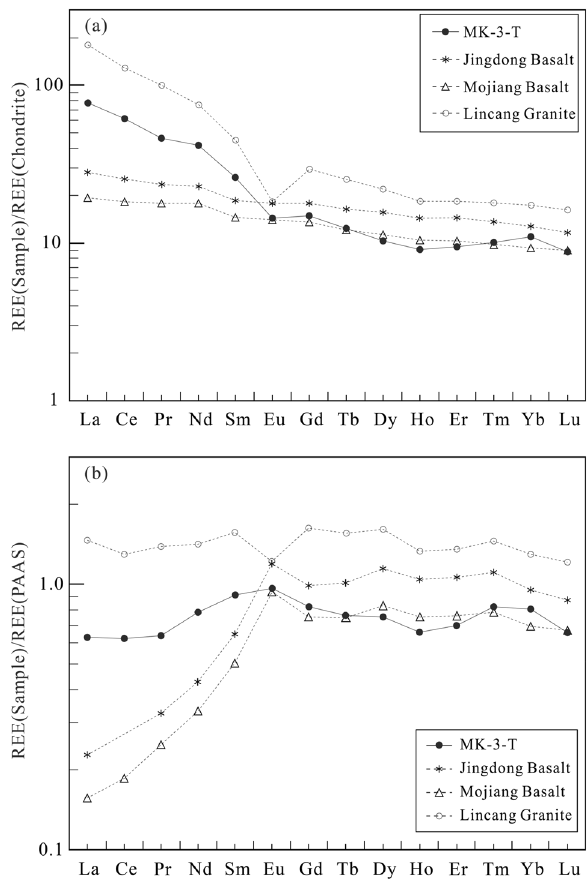
Figure 8. Distribution patterns for REEs in sample MK-3-T, basalt from Jingdong 24 and Mojiang 25 and granite from Lincang 25 (Chondrite date according to reference 26 ; PASS date according to reference 27 ). The REE distribution patterns of the sample are between those of acidic igneous rocks and basic igneous rocks in the research